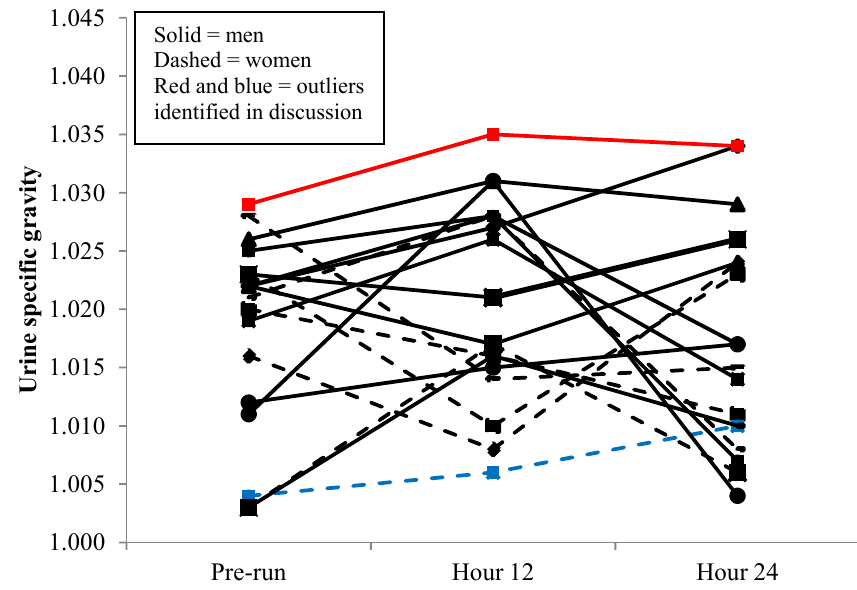
Figure 4. Individual changes in urine specific gravity ( n = 19 *). * 1 male was unable to provide a pre-run urine